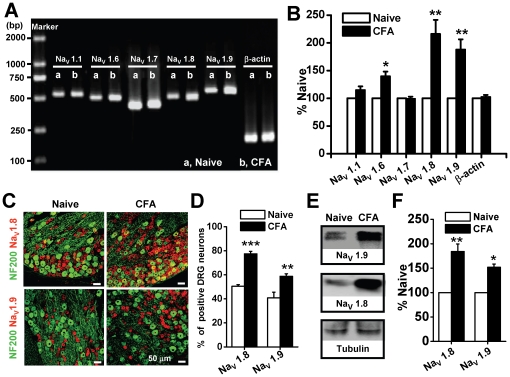
Expression profile of NaV1.8 and NaV1.9 at mRNA and protein levels following CFA treatment.(A) Representative RT-PCR results of five isoforms of voltage-gated sodium channels. Amplicons of NaV1.1, NaV1.6, NaV1.7, NaV1.8, NaV1.9 and ß-actin were 540 bp, 509 bp, 441 bp, 515 bp, 572 bp and 229 bp, respectively. (B) Averaged fold changes of mRNA expression as normalized with naive control (n = 3). (C) Double immunofluorescent labeling of DRG neurons by anti-NaV1.8 (red) and anti-NF-200 (green) or anti-NaV1.9 (red) and anti-NF-200 (green) antibodies. (D) The percentage of Nav1.8- and Nav1.9-positive profiles as a proportion of the total number of DRG neurons before and after CFA treatment (n = 8). (E) Western blotting examples of NaV1.8 and NaV1.9 in naive and CFA-treated DRG neurons. (F) Averaged protein expression of NaV1.8 and NaV1.9 between naive and CFA-treated DRGs (normalized with the internal control tubulin) (n = 3 for each group). CFA, complete Freund's adjuvant. * p<0.05, **p<0.01, ***p<0.001.